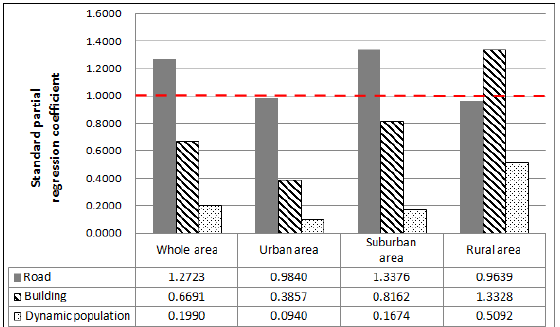
Figure 8. Standard partial regression coefficients in each area